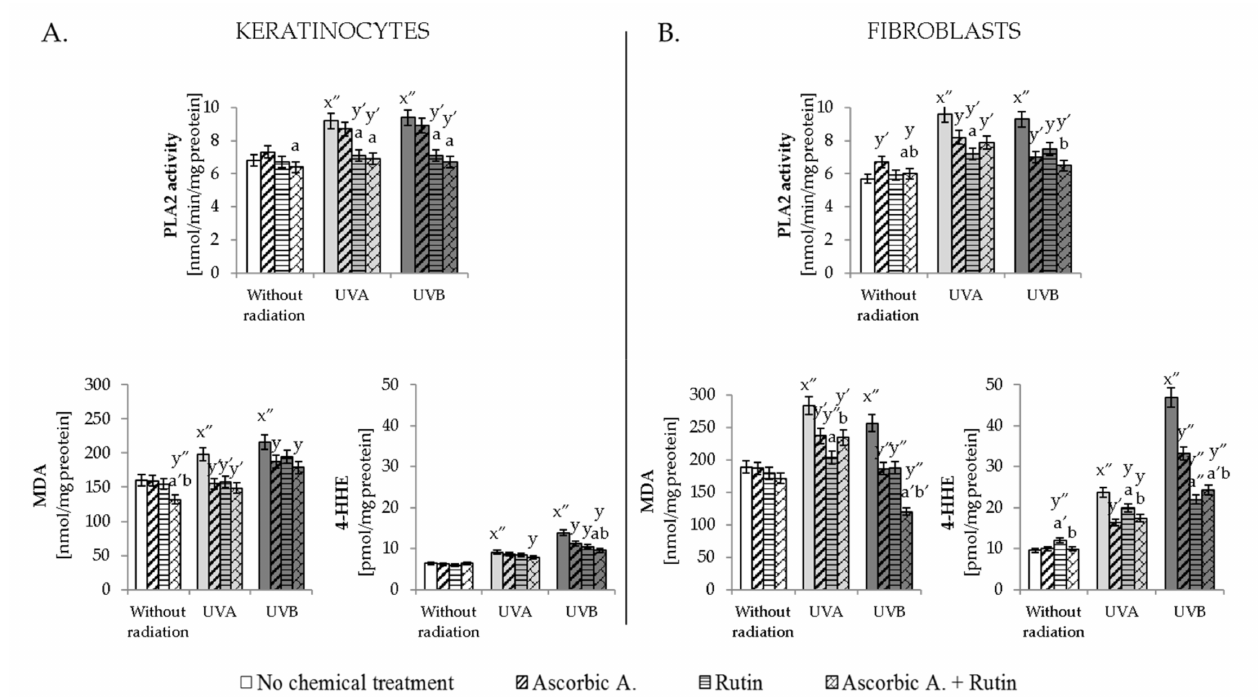
Figure 3. The activity of lipid metabolizing enzyme phospholipase A2 (PLA2) and levels of lipid peroxidation products (MDA and 4-HHE) in keratinocytes ( A ) and fibroblasts ( B ) exposed to UVA (30 J/cm 2 and 20 J/cm 2 , respectively) and UVB irradiation (60 mJ/cm 2 and 200 mJ/cm 2 , respectively) and treated with rutin (25 µ M) and ascorbic acid (100 µ M). Mean values ± SD of three independent experiments are presented. x significant differences vs. non-treated group, respectively (x (cid:48)(cid:48) for p < 0.0005); y significant differences vs. group without chemical treatment, respectively (y for p < 0.05; y (cid:48) for p < 0.005, y (cid:48)(cid:48) for p < 0.0005); a significant differences vs. ascorbic acid-treated group, respectively (a for p < 0.05; a (cid:48) for p < 0.005, a (cid:48)(cid:48) for p < 0.0005); b significant differences vs. rutin-treated group, respectively (b for p < 0.05; b (cid:48) for p <